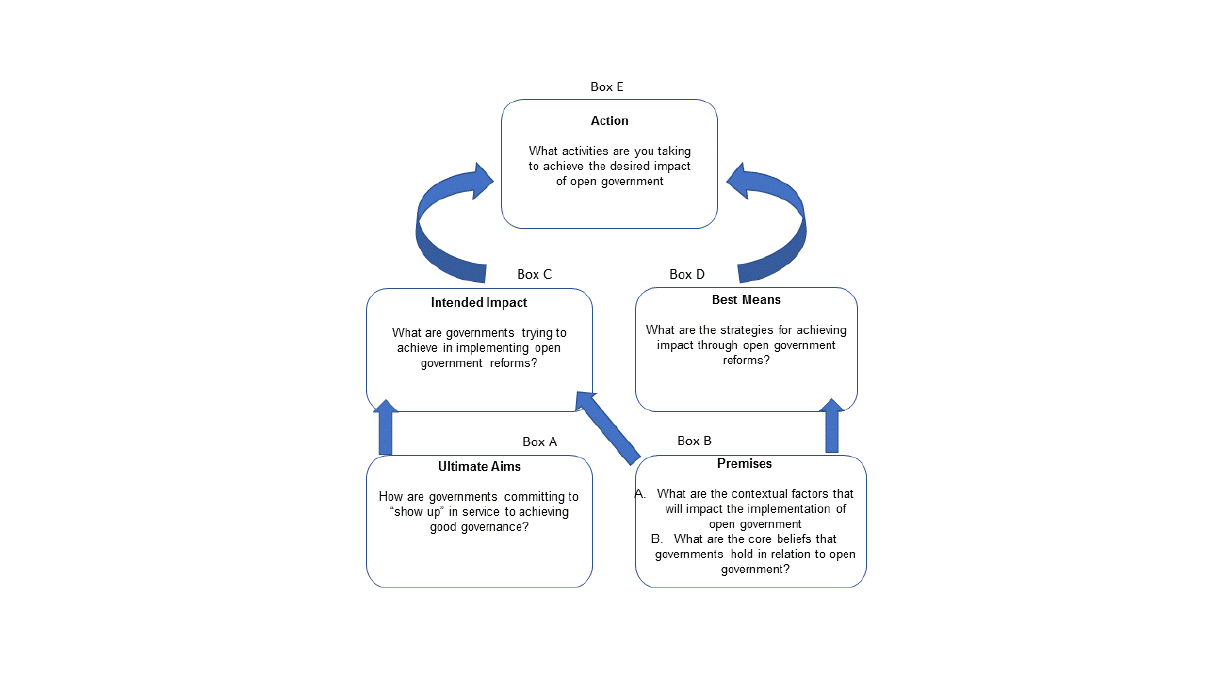
Figure 1: Dialogue Box